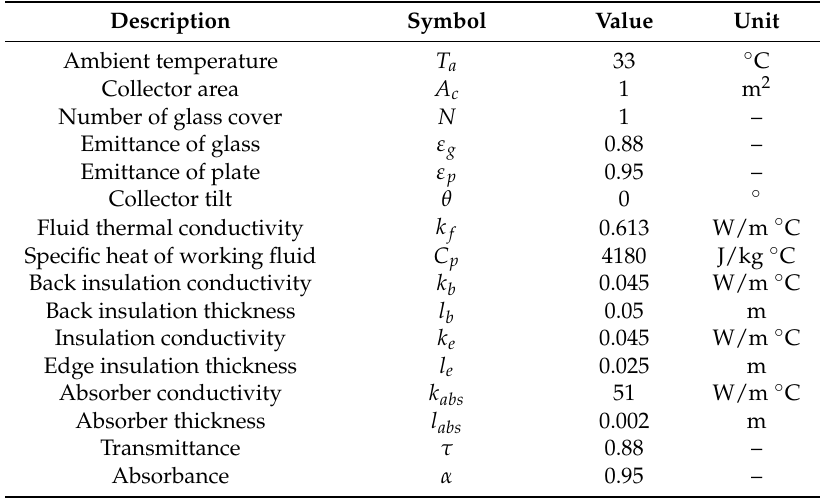
Table 2. PVT solar collector